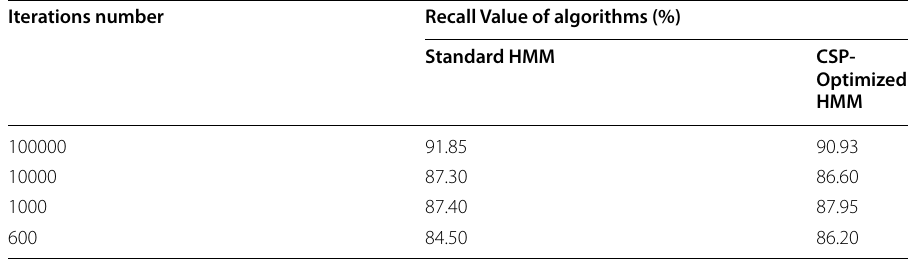
Table 7 Recall values comparison